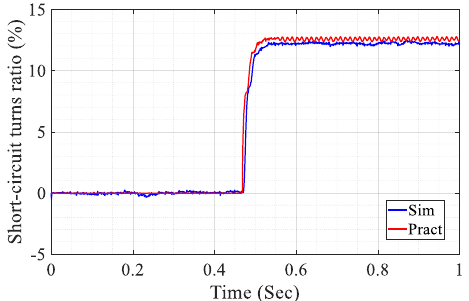
Figure 28. Estimation of 12% short circuit turns ratio in phase A.